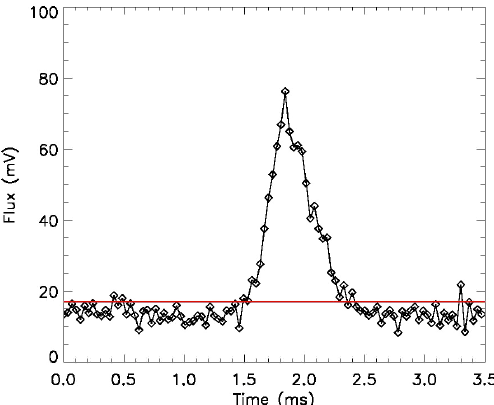
Figure 3. Example of the output voltage recorded by the 12 ◦ chan- nel photodiode for ambient air particles crossing the laser beam. The red line corresponds to the threshold for the peak detection. When a particle is detected, the signal must return back below the threshold to allow the detection of the next